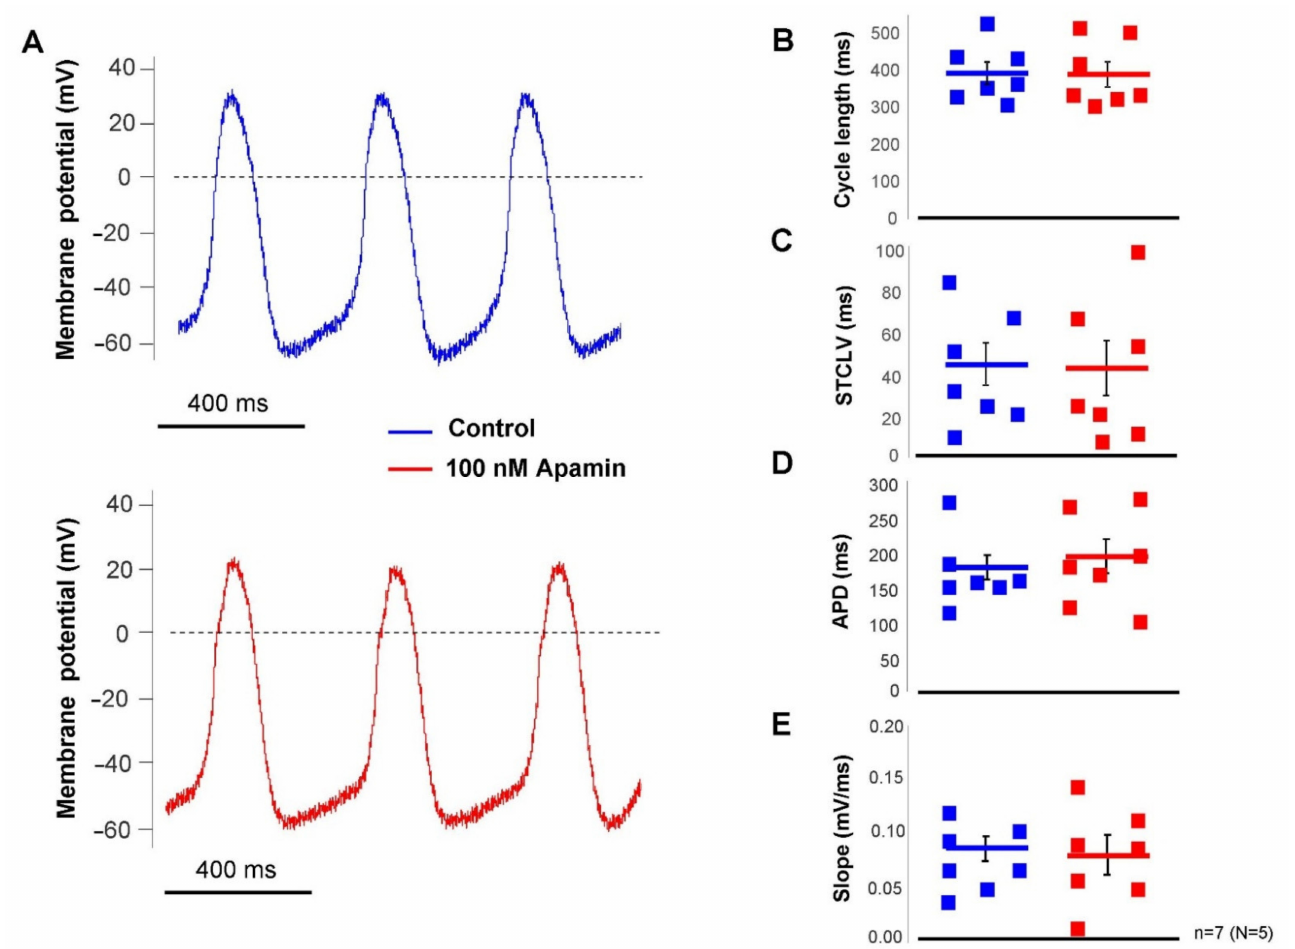
Figure 5. Action potential recordings from isolated SAN cells by perforated patch-clamp technique under normal condition. After control recordings (blue curve), 100 nM apamin was employed (red curve, ( A ). Bar graphs reported identical cycle lengths ( B ), short-term cycle length variability ( C ), APD ( D ), and slope of diastolic depolarization ( E ). Statistical analysis was performed by paired t